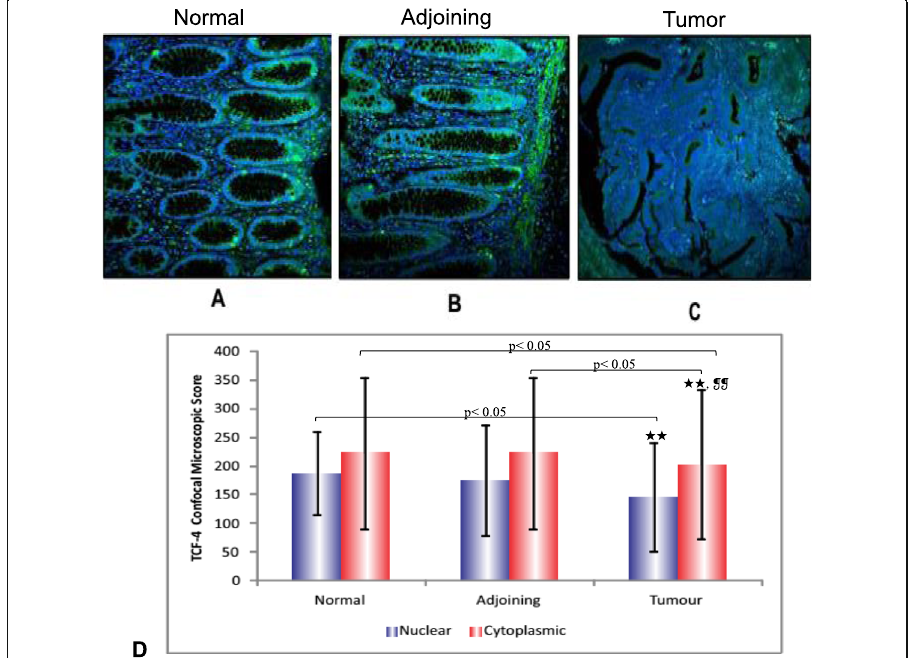
Fig. 4 TCF-4 protein expression by confocal microscopy. a, b & c show confocal immunofluorescent images of TCF-4 protein in normal ( a ), adjoining ( b ) and tumor tissue ( c ) from CRC patients. Magnification X=200. d presents a histogram that shows differential nuclear and cytoplasmic protein expression of TCF-4 protein by confocal microscopy in normal, adjoining and tumor tissues. * indicates p value between nuclear protein levels, ❡ indicates p values between cytoplasmic protein